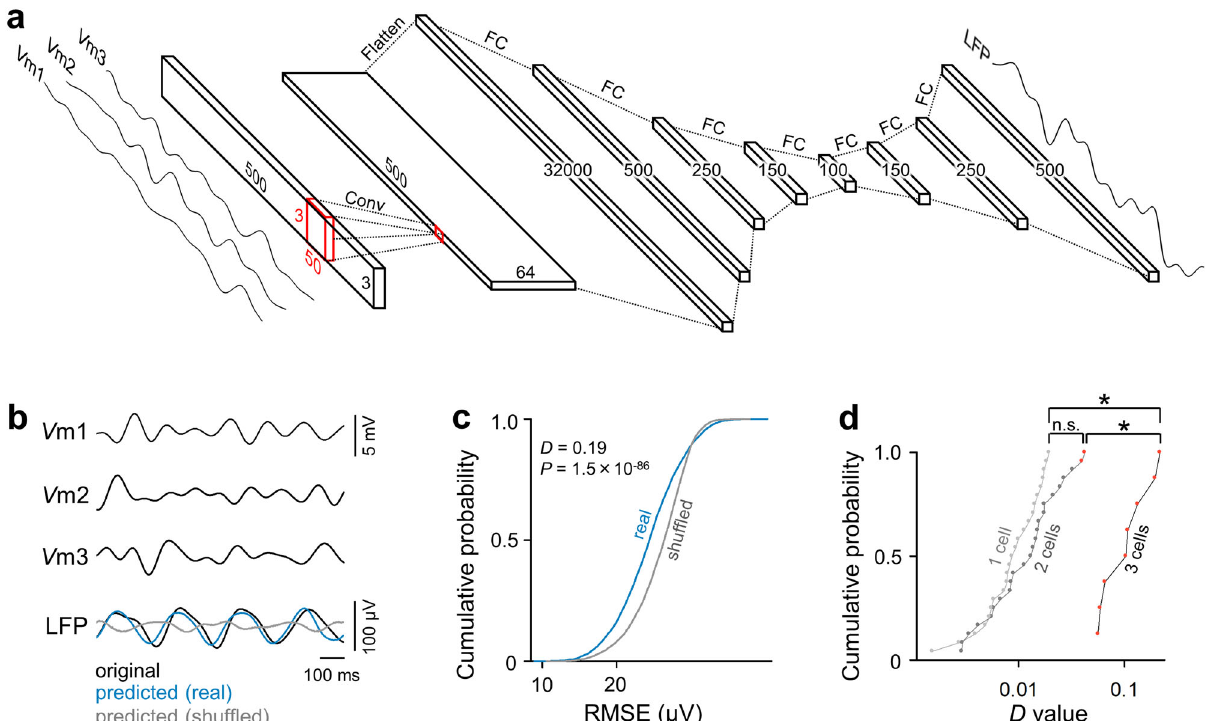
Fig. 5 Prediction of θ LFP from θ V m s. a Architecture of our neural network model. The numbers indicate the channel features (bin) in each layer. Conv: convolutional, FC: fully connected. The model input was three simultaneously recorded V ms ( V m1, V m2, and V m3) that were bandpass fi ltered between 3 and 10Hz (left). The model was trained to output the corresponding bandpass- fi ltered LFPs (right). In d , one or two V ms were used as the inputs. b Representative traces of three V ms, the original LFPs (black), and the LFPs predicted from the real data (blue) or shuf fl ed data (gray). The V m and the original LFP traces were bandpass fi ltered between 3 and 10Hz. The shuf fl ed data were created by randomizing the temporal order of all 1-s segments within each cell and used to train the neural network. c Cumulative probability distribution of the root mean squared errors (RMSEs) between the original LFP waveforms and the LFP waveforms predicted from real or shuf fl ed data. P = 1.5×10 − 86 , D = 0.19, two-sample Kolmogorov ‒ Smirnov test, n = 2310 1-s segments in a single dataset. d Cumulative probability distribution of the D -values calculated as in c for all 8 datasets with LFPs and V ms of 3 cells, as well as 24 datasets with LFPs and V ms of 1 or 2 cells. Each dot indicates a single dataset, and red dots indicate signi fi cant D- values. The LFP waveforms were better predicted from V ms of 3 cells than those of 1 or 2 cells. D 1 vs . 2 cells = 0.25, P 1 vs . 2 cells = 0.39, D 1 vs . 3 cells = 1.0, P 1 vs . 3 cells = 2.3×10 − 6 , D 2 vs . 3 cells = 1.0, P 2 vs . 3 cells = 2.3×10 − 6 , two-sample Kolmogorov ‒ Smirnov The same analysis was conducted using bandpass- fi ltered traces at 60 – 100 Hz (high gamma), 25 – 55 Hz (low gamma), and 0.5 – 1 Hz (slow oscillations). In contrast to the fi ndings with the θ frequency band, signi fi cantly higher accuracies were obtained in only a small proportion of the datasets, regardless of the number of cells used for the prediction (Supplementary Fig. 11, high gamma: 5/24 datasets for 1 cell and 2/24 datasets for 2 cells; low gamma: 1/24 dataset for 1 cell and 2/24 datasets for 2 cells; slow oscillations, 4/ 24 datasets for 1 cell, 4/24 datasets for 2 cells and 2/8 datasets for 3 cells). For all three frequency bands, increases in the number of cells used for the predictions did not correspond to an increase in the prediction accuracy (Supplementary Fig. 11a, D 1 vs . 2 cells = 0.17, P 1 vs . 2 cells = 0.86, D 1 vs . 3 cells = 0.50, P 1 vs . 3 cells = 0.066, D 2 vs . 3 cells = 0.46, P 2 vs . 3 cells = 0.11; Supplementary Fig. 11b, D 1 vs . 2 cells = 0.21, P 1 vs . 2 cells = 0.62, D 1 vs . 3 cells = 0.25, P 1 vs . 3 cells = 0.79, D 2 vs . 3 cells = 0.78, P 2 vs . 3 cells = 0.29; Supplementary Fig. 11c, D 1 vs . 2 cells = 0.46, P 1 vs . 2 cells = 0.0082, D 1 vs . 3 cells = 0.33, P 1 vs . 3 cells = 0.43, D 2 vs . 3 cells = 0.50, P 2 vs . 3 cells = 0.066; two-sample Kolmogorov ‒ Smirnov test, n = 24, 24, and 8 datasets for 1, 2, and 3 cells, respectively). To examine the relationships among LFPs and V ms in frequency bands other than θ , we calculated the cross-correlograms between pairs of bandpass- fi ltered LFPs, the correlation coef fi cients between LFP and V m powers of single cells, and the correlation coef fi cients between LFPs and the mean V m power of three simultaneously recorded cells for all three frequency bands. Overall,